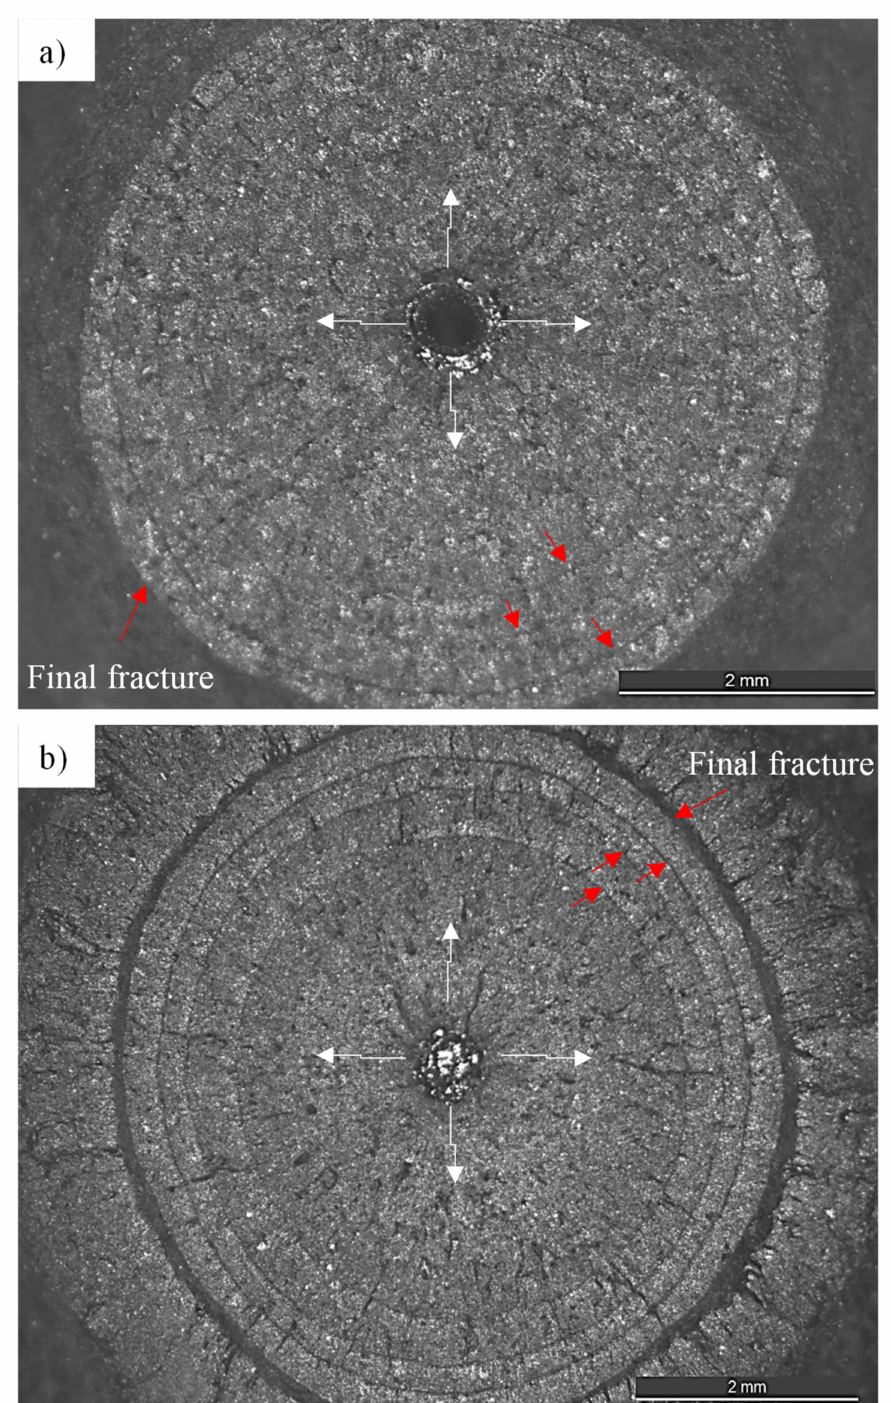
Figure 4. Fracture surfaces. ( a ) Crack propagation in air. ( b ) Crack propagation in